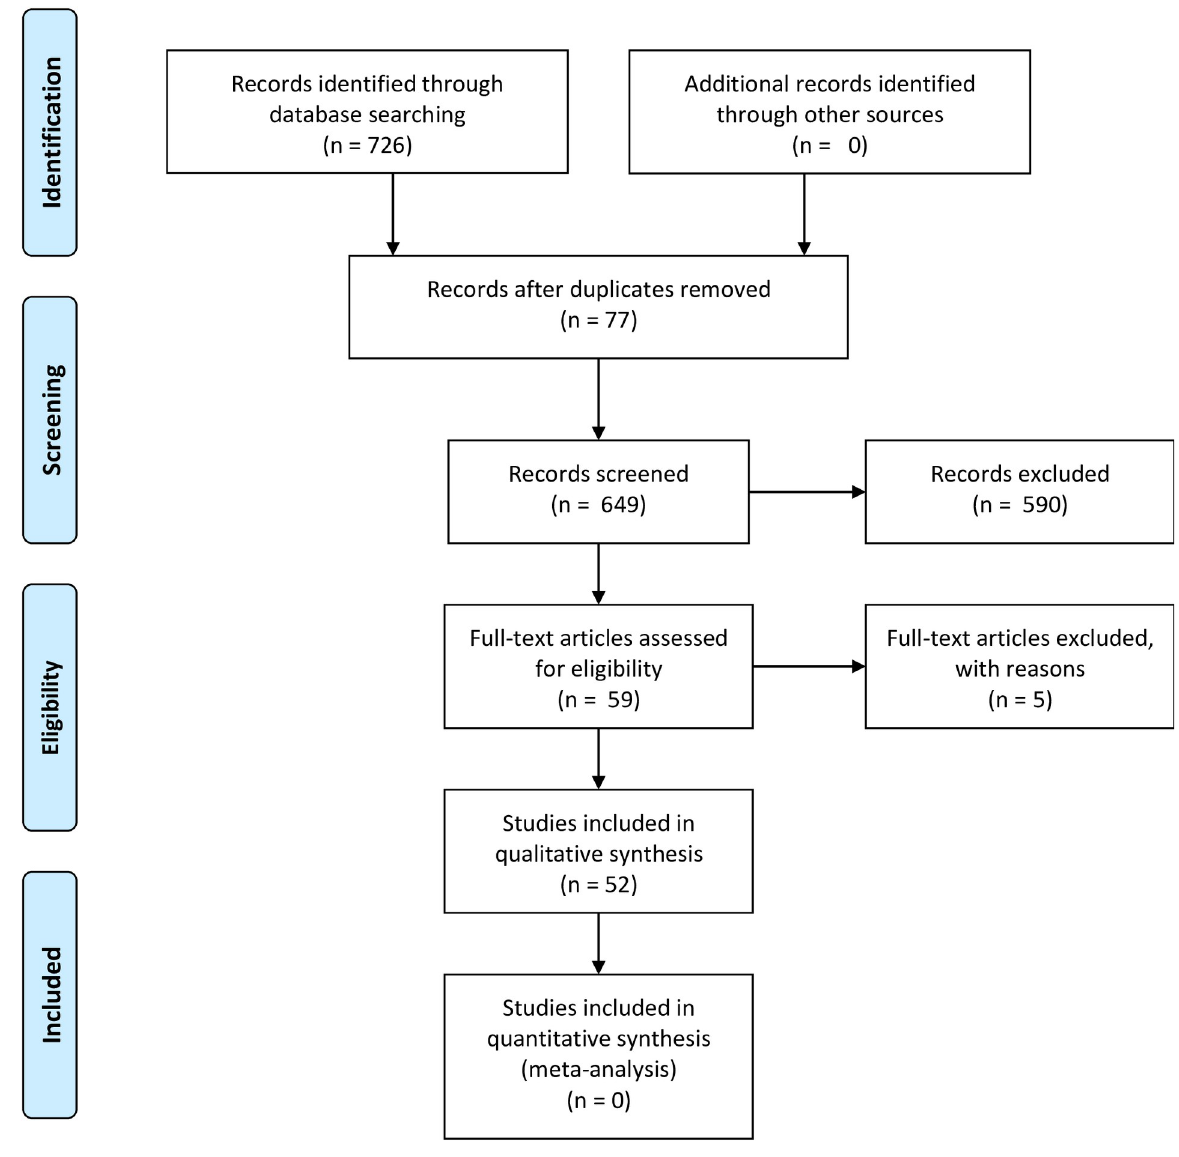
Fig 1. Flowchart of the study selection